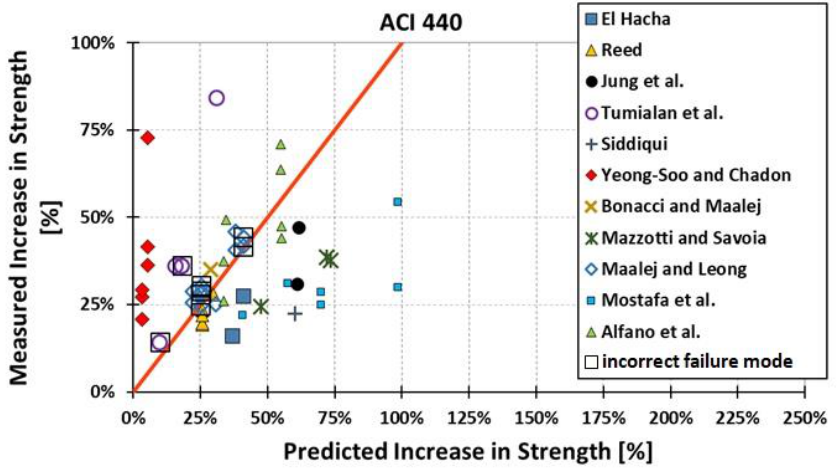
Figure 18. Measured increase in flexural strength versus ACI 440 prediction.